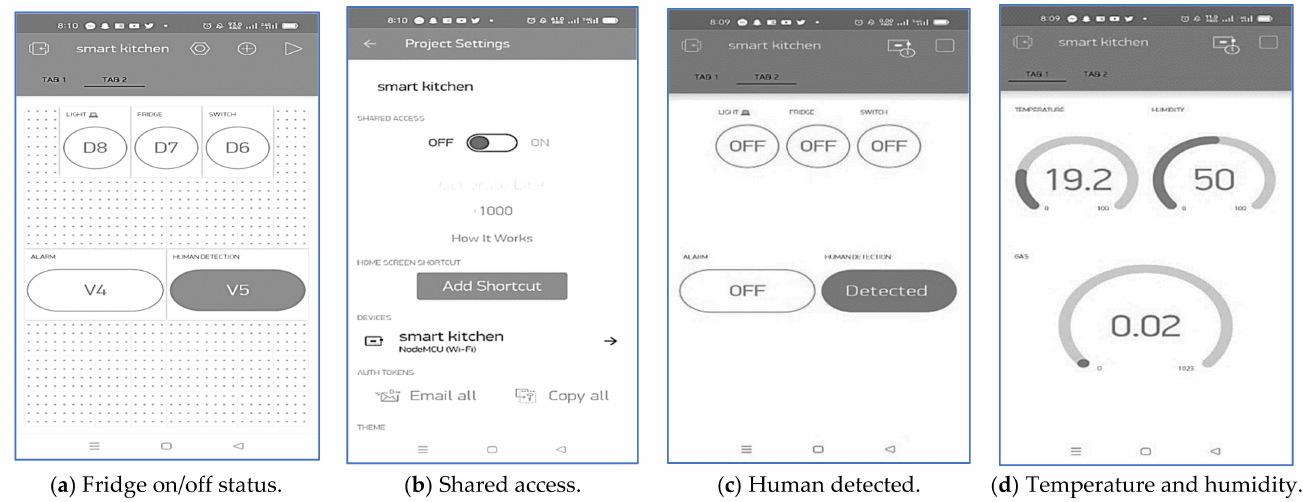
Figure 6. Monitoring and Automation through Integrated Android